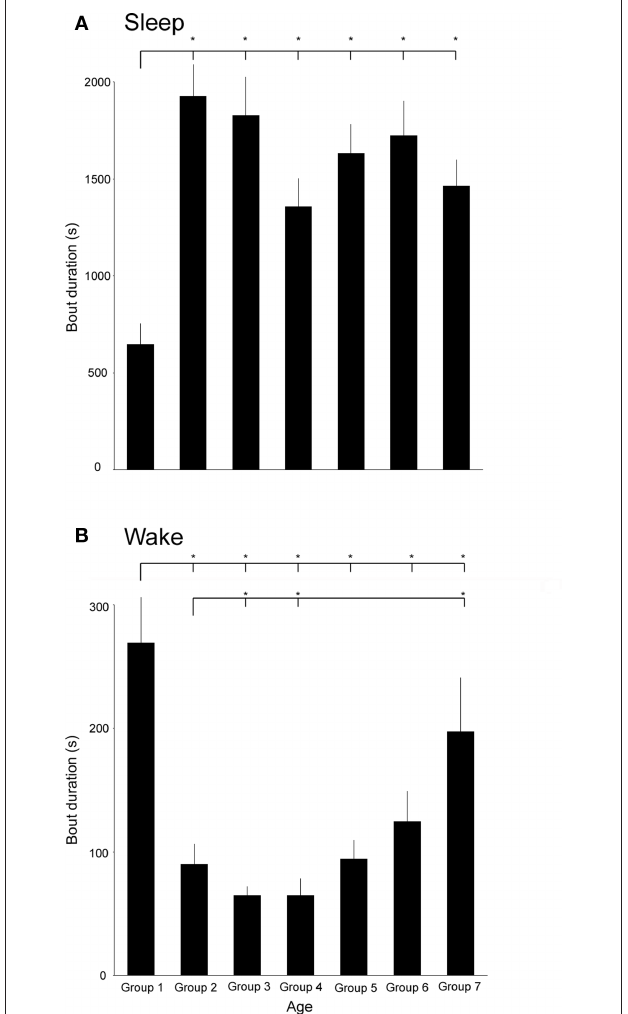
FiGure 2 | (A) Mean sleep bout durations in age groups 1–7. Line and asterisk indicate that the mean sleep bout duration of age group one is significantly smaller than in all other groups. (B) Mean wake bout durations in the age groups 1–7. Lines and asterisks indicate that the mean wake bout duration of age group one is significantly larger than in all other groups except group 7 and the mean wake bout duration is significantly longer in age group 7 than in groups 2–4.